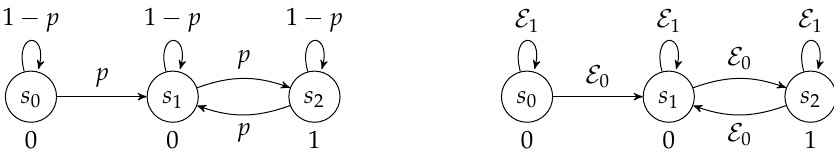
Figure 2. Example showing that BSCC decomposition for the underlying graph does not work for model checking parity